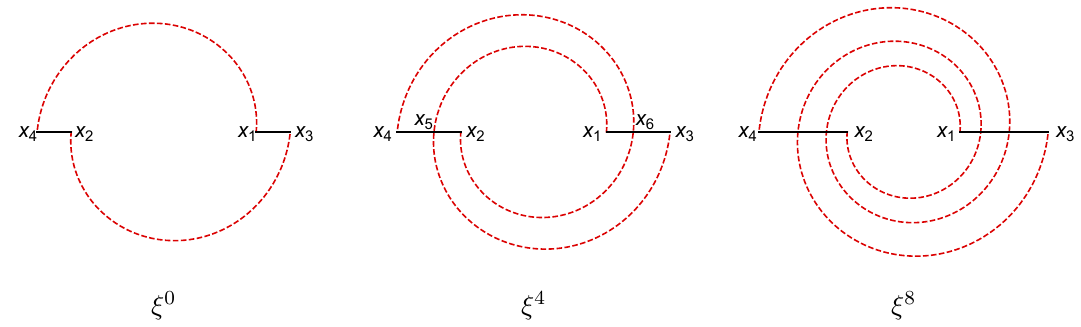
Figure 10 . First 3 orders contributing to the G 2